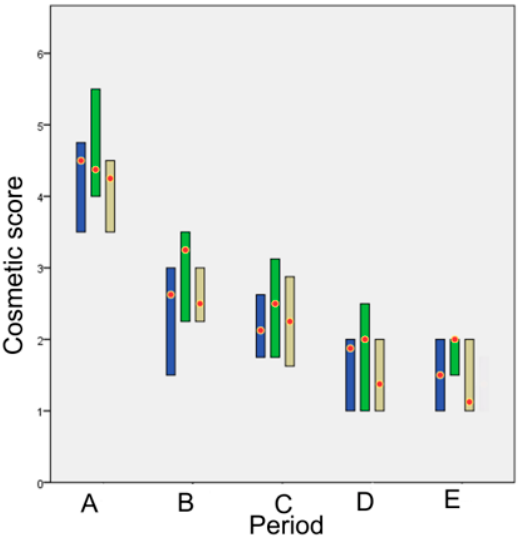
Figure 1. Median score (red dot) and interquartile range (column) of the total cosmetic score for each technique (blue: staples, green: glue, gray: intradermal) in each time period. [period A: 1–8 po.d.; period B: 9–21 po.d.; period C: 22–63 po.d.; period D: 64–180 po.d.; period E: 181–365 po.d.]. Differences were statistically significant between glue and intradermal in Period E ( p <0.001).